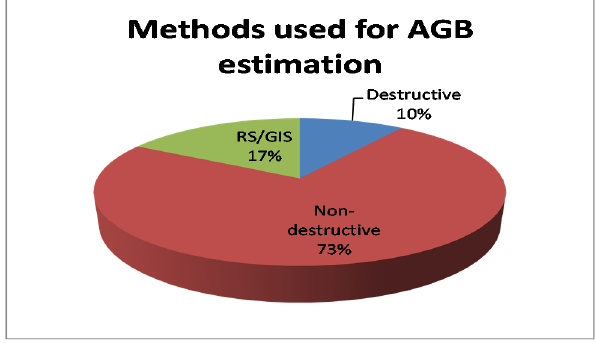
Figure 3. Above-ground biomass estimation methods used in Pakistan.